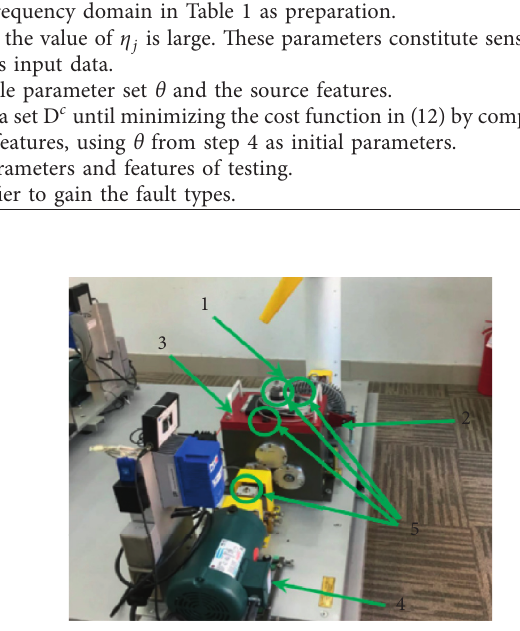
Figure 4: Appearance of WTDS: 1-magnetic brake, 2-planetary gearbox, 3-fixed axis gearbox, 4-motor, and